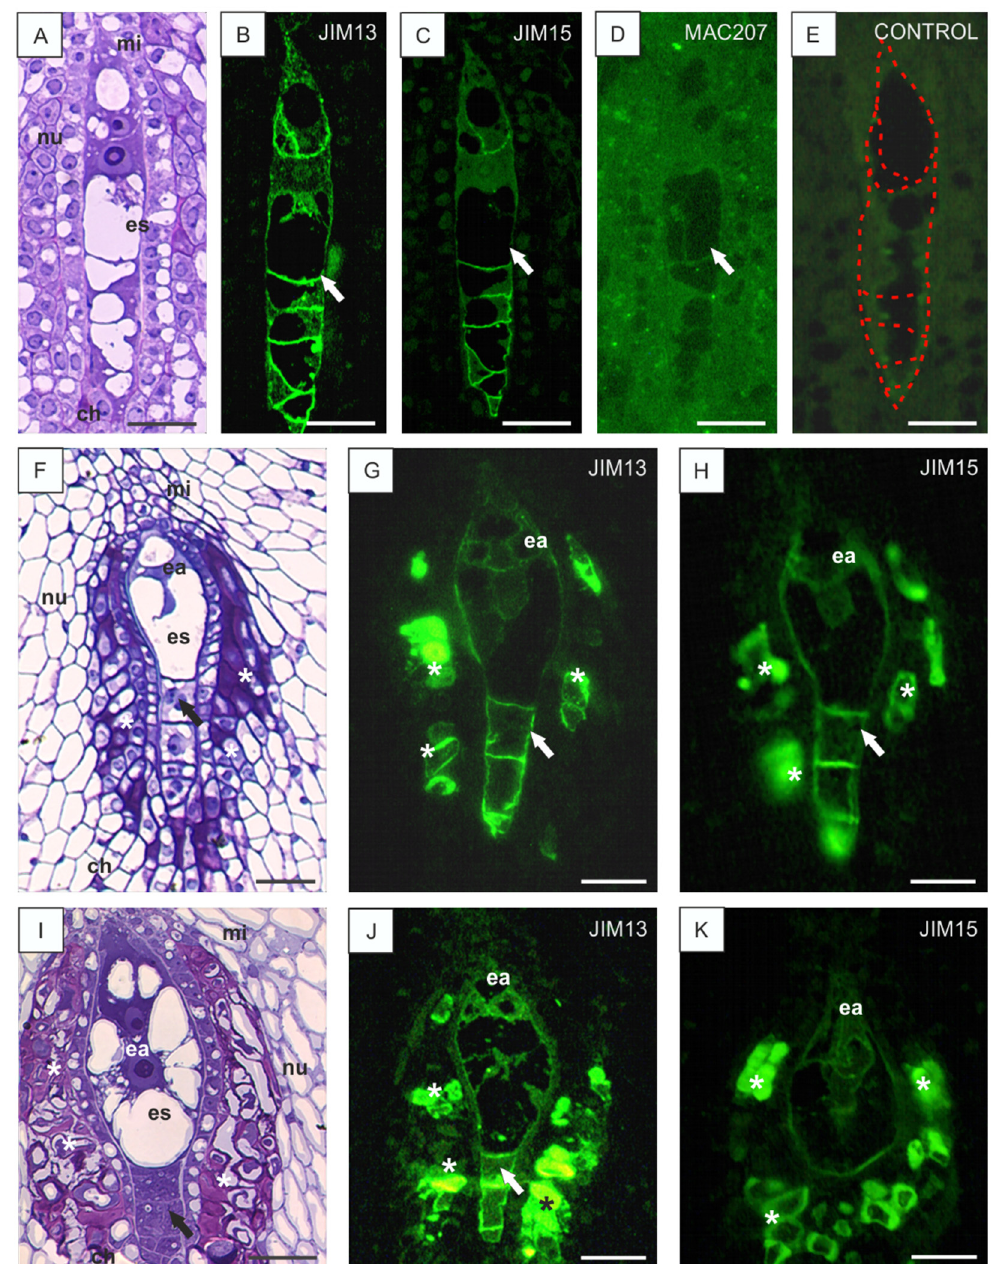
Figure 2. Histology of B. perennis ovules and immunolocalization of AGP epitopes during embryo sac development. Ovule nucellus with an embryo sac at an early stage of development ( A ). AGPs in the cell walls of the embryo sac (arrow); reaction with JIM13 ( B ), JIM15 ( C ), and MAC207 ( D ). Marked embryo sac ( E ). Later stage of embryo sac development than that shown in ( A – E ) ( F ). AGPs in the cell walls of the embryo sac and in cells surrounding the female gametophyte (asterisks); reaction with JIM13 ( G ) and JIM15 ( H ). Mature embryo sac at advanced stages of development ( I ). AGPs in the cell walls of the embryo sac and egg apparatus, reaction with JIM13 ( J ) and JIM15 ( K ). In ( F – J ) arrows point antipodal cells. In ( G , H , J , K ) asterisks point the integumental tapetum. Toluidine blue staining: ( A , F , I ). Immunolabeling: ( B – E , G , H , J , K ). Bars: 20 µ m ( A – K ). Abbreviations: ch—chalazal pole, ea—egg apparatus, es—embryo sac, mi—micropylar pole, nu—nucellus.